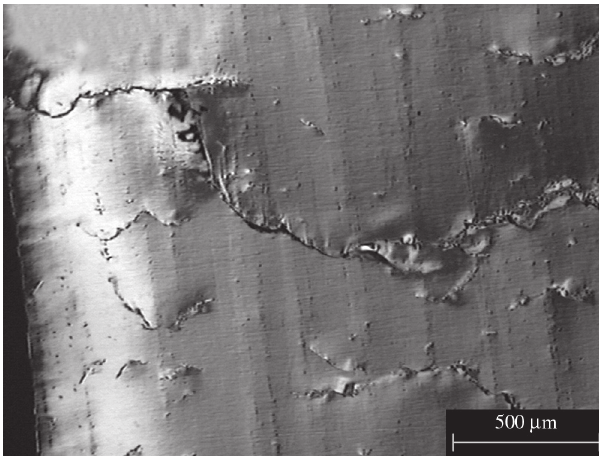
Figure 8. Fatigue surface analysis by differential interference contrast. Diffuse crack propagation is observed, with an intense secondary cracking. Original